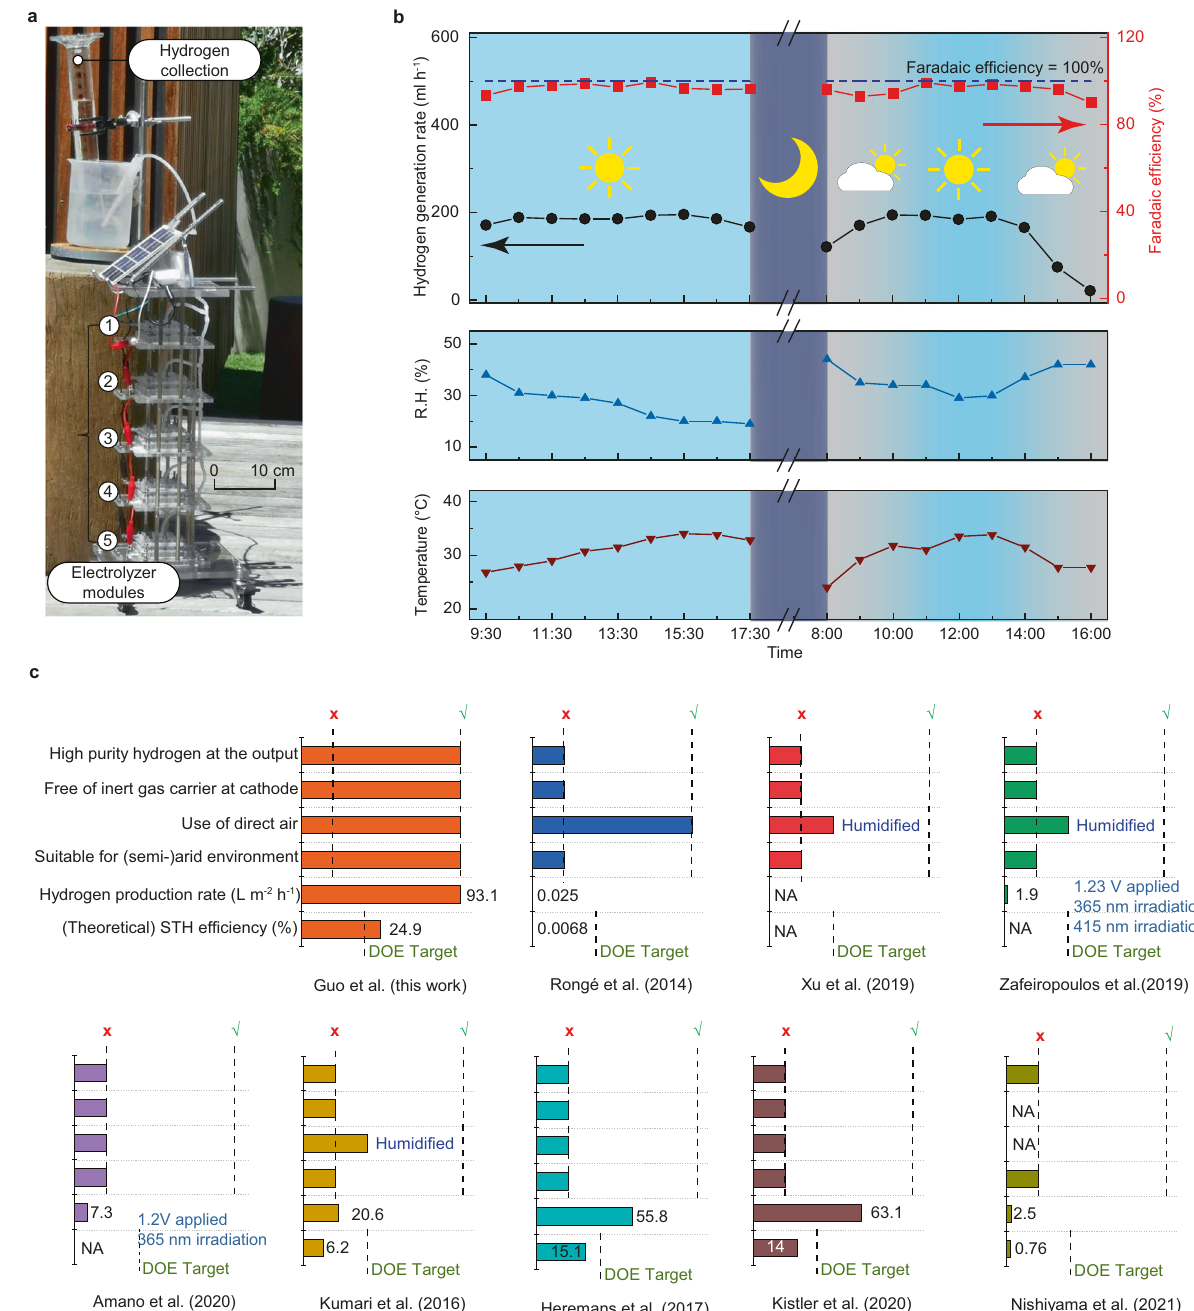
Fig. 4 | Open-airdemonstration ofthehydrogen generationtowerinDec 2020 Melbourne.a Photoofthedesignedhydrogengenerationtowerfeaturingscalable DAE modules with minimized footprint. b Hydrogen generation rate and Faradaic ef fi ciency on an hourly basis at corresponding air humidity and temperature for